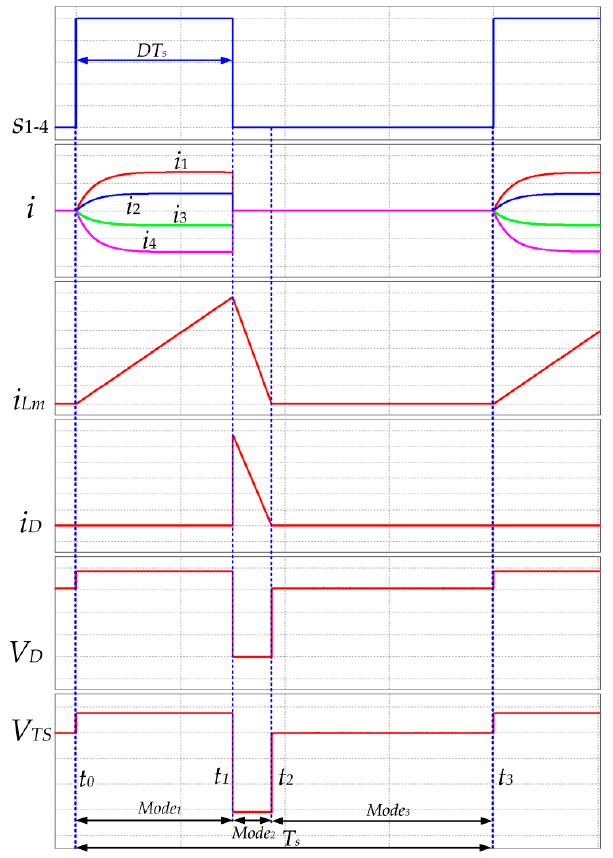
Figure 3. Operation waveforms of the cell balancing circuit.